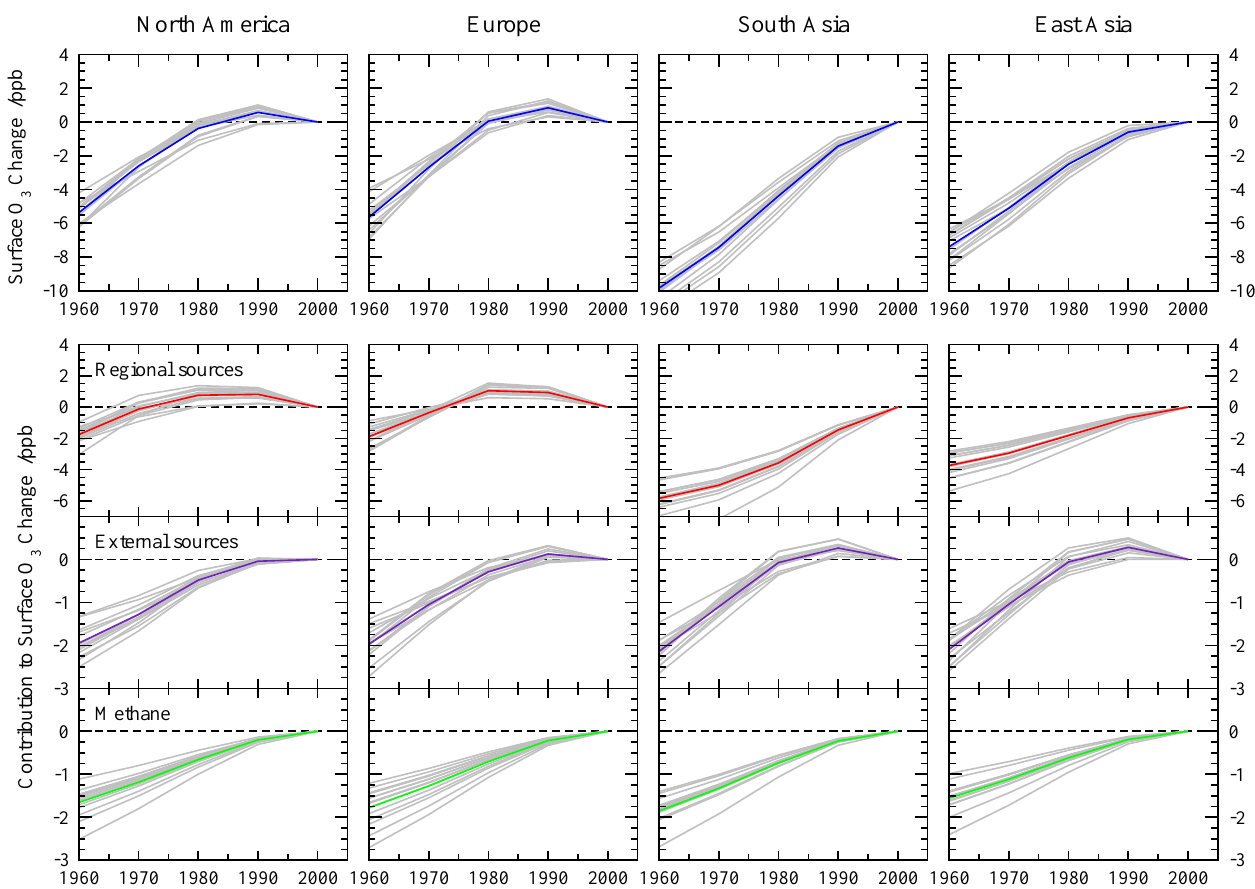
Fig. 6. Annual regional mean surface O 3 changes relative to 2000 over each HTAP region following historical precursor emission changes between 1960 and 2000 (top row), and the contribution of regional anthropogenic sources, anthropogenic sources outside the region, and global methane changes (bottom row). Individual model responses are shown in grey and the mean of all 14 models is